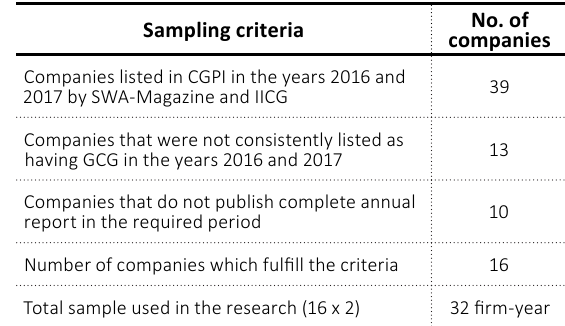
Table 1. Summary of the sample observed Sampling